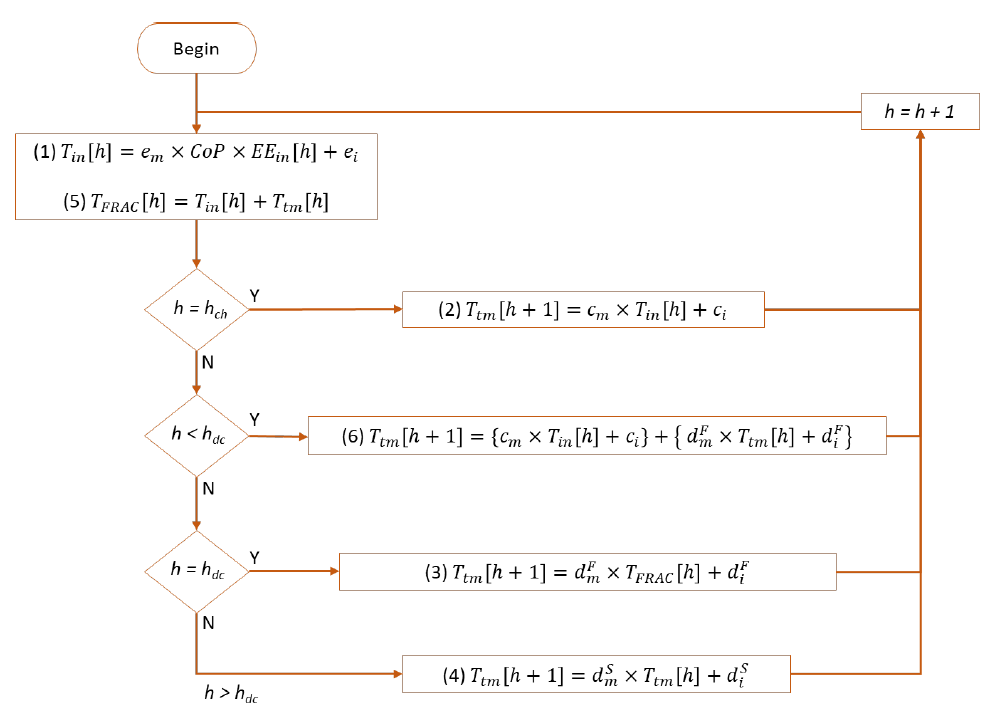
Figure 6. Flowchart describing the process for implementing the model.